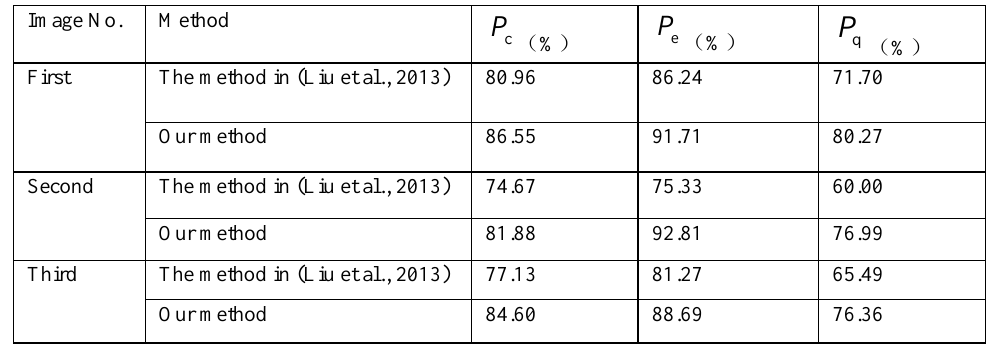
Table 2. Statistics about the accuracy of human settlements